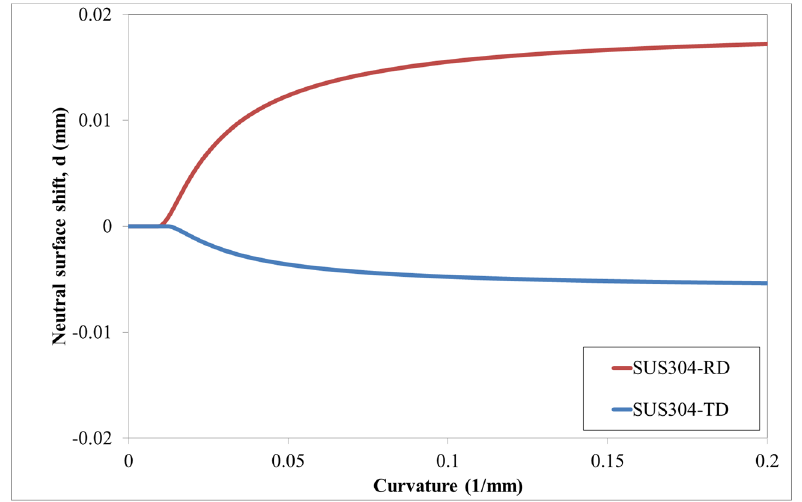
Figure 8. Variation of the neutral surface shift from the midplane versus curvature.